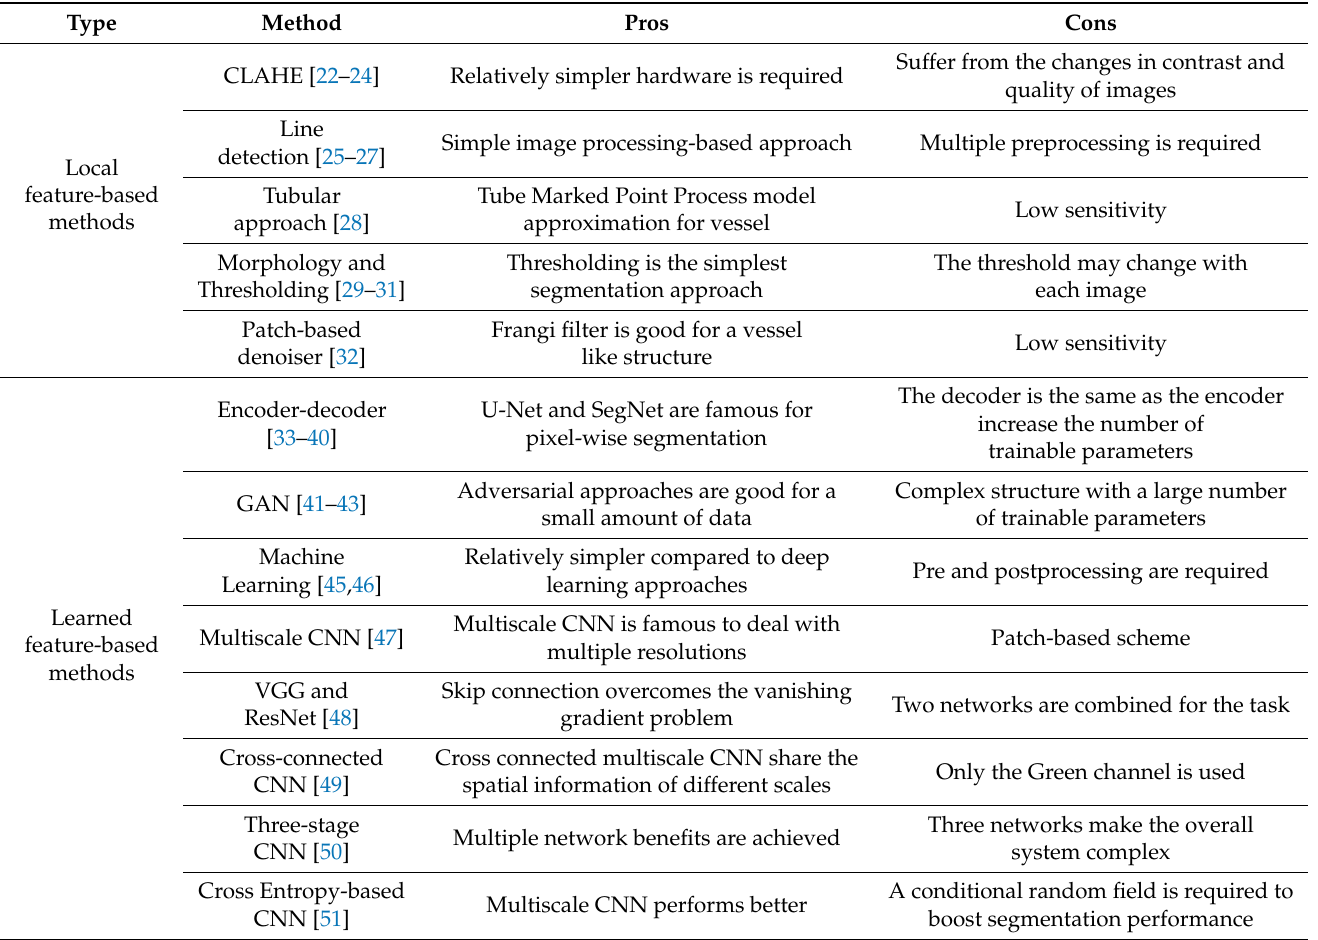
Table 2. Pros and cons of the